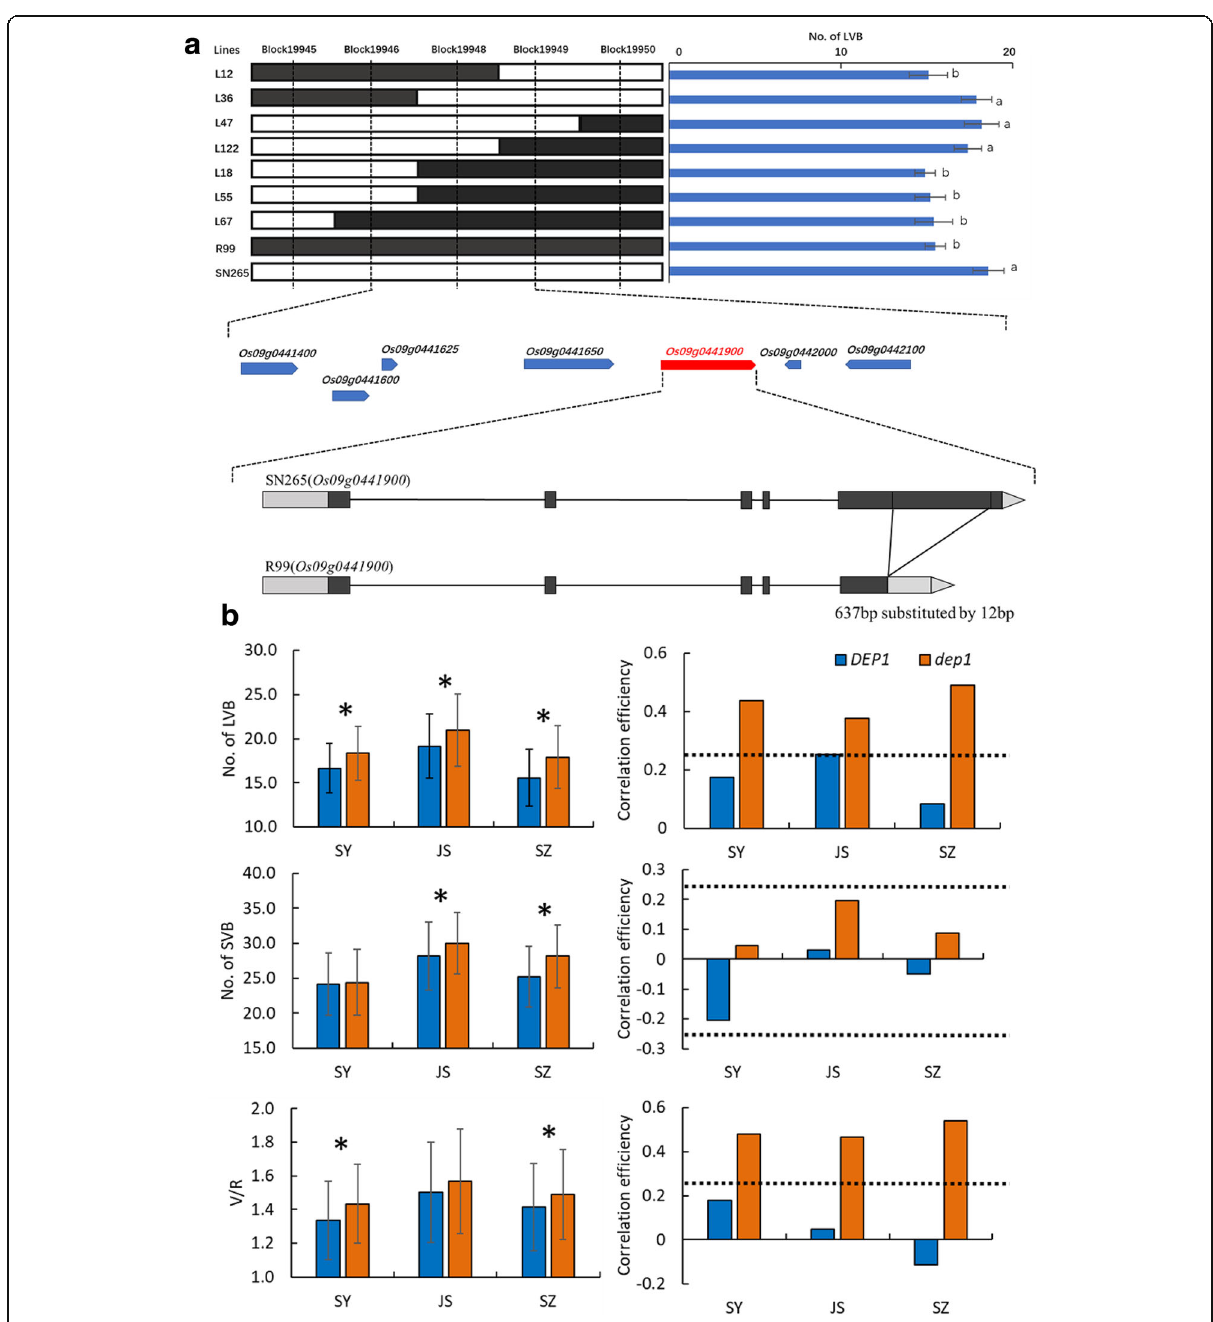
Fig. 3 The fine mapping of qLVB9 and the function change of qLVB9. a The candidate gene qLVB9 was identified as Os09g0441900/DEP1 . b The different functions of the normal DEP1 allele and truncated dep1 allele among three areas, and the correlation efficiency between vascular bundles traits and indica pedigree of these two alleles in three areas. * represents significance at the 5% level, the dotted lines indicate significance at the 5%